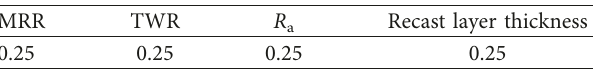
Table 6: Weights of the response